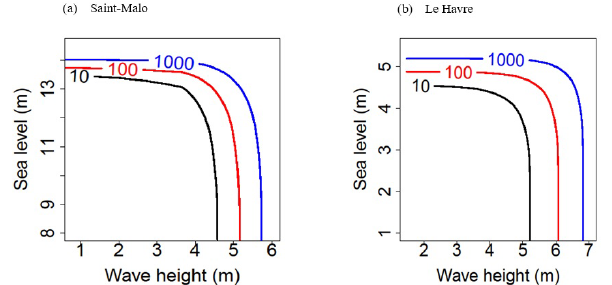
Figure 8. Joint exceedance probability obtained with (a) the Clay- ton copula (0.38) for Saint-Malo (b) with the Clayton copula (0.74) for Le Havre with tide for return periods of 10, 100 and 1000